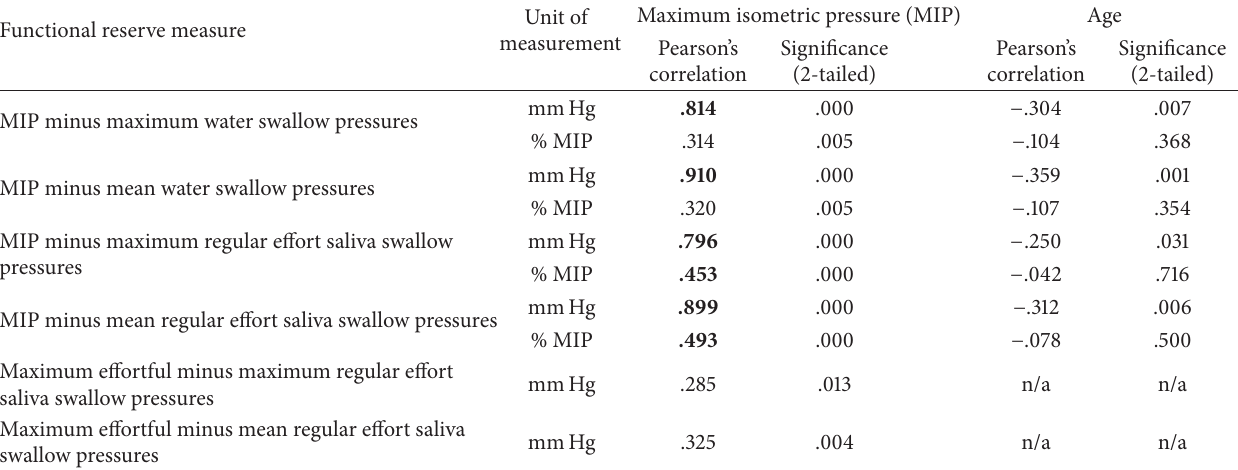
Table 1: Pearson’s correlations between different measures of functional reserve: maximum isometric pressure and age. Functional reserve